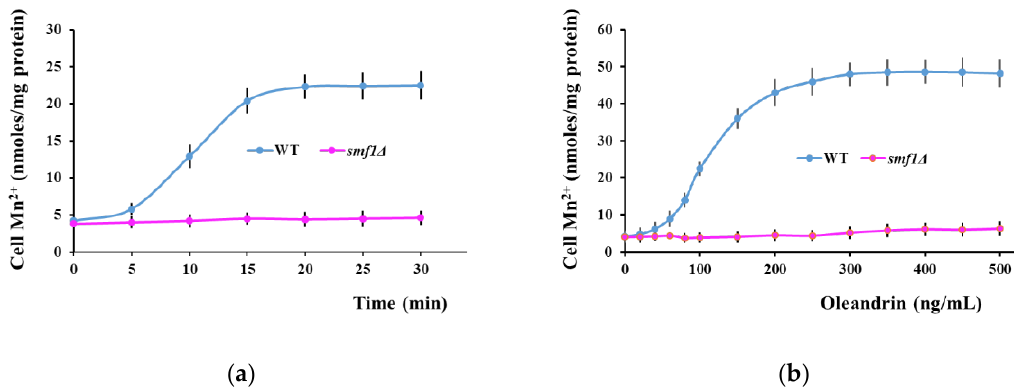
Figure 3. Oleandrin induces Smf1-dependent Mn 2+ accumulation in yeast cells. ( a ) Time course of Mn 2+ accumulation following oleandrin exposure. Exponentially growing wild type and smf1Δ cells were treated with oleandrin (100 ng/mL) and samples were collected every 5 min for Mn 2+ assay. ( b ) Effect of oleandrin concentrations on Mn 2+ accumulation. Exponentially growing wild type and smf1Δ cells were treated with increasing oleandrin concentrations and samples were collected after 20 min for Mn 2+ assay. Cells were incubated (30 °C, 200 rpm) in liquid MMe containing 1 μM MnCl 2 . *** p < 0.005, Student’s t test.